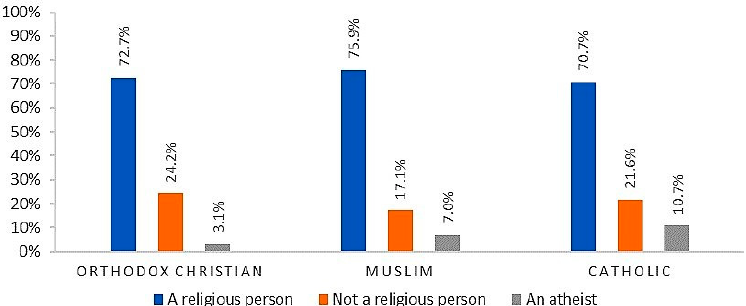
Figure 3. Religious self-declaration by confession.